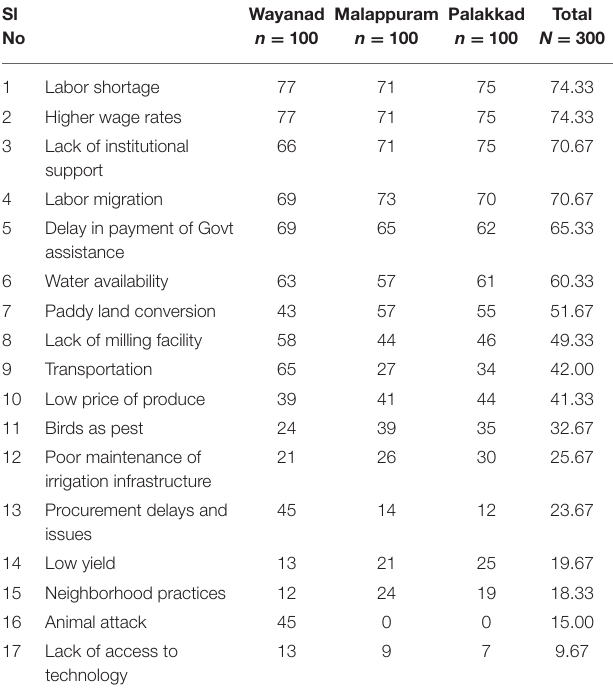
TABLE 5 | Constraints experienced by farmers in traditional rice